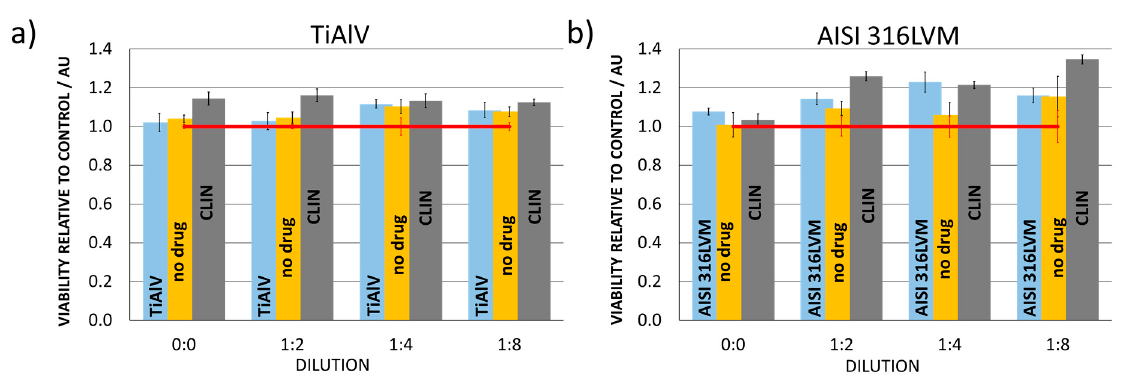
Figure 6. Osteoblast cell viability determination for ( a ) TiAlV substrate, 3D-printed coating on TiAlV substrate (no drug), and CLIN-loaded 3D-printed coating on TiAlV substrate (CLIN) and ( b ) AISI 316LVM substrate, 3D-printed coating on AISI 316LVM substrate (no drug), and CLIN-loaded 3D-printed coating on AISI 316LVM substrate (CLIN) using the MTT (3(4,5 dimethylthiazolyl-2)-2,5-diphenyltetrazolium) assay and the control (cell growth in the advanced DMEM and FBS medium indicated by red line). Error bars represent standard deviation.